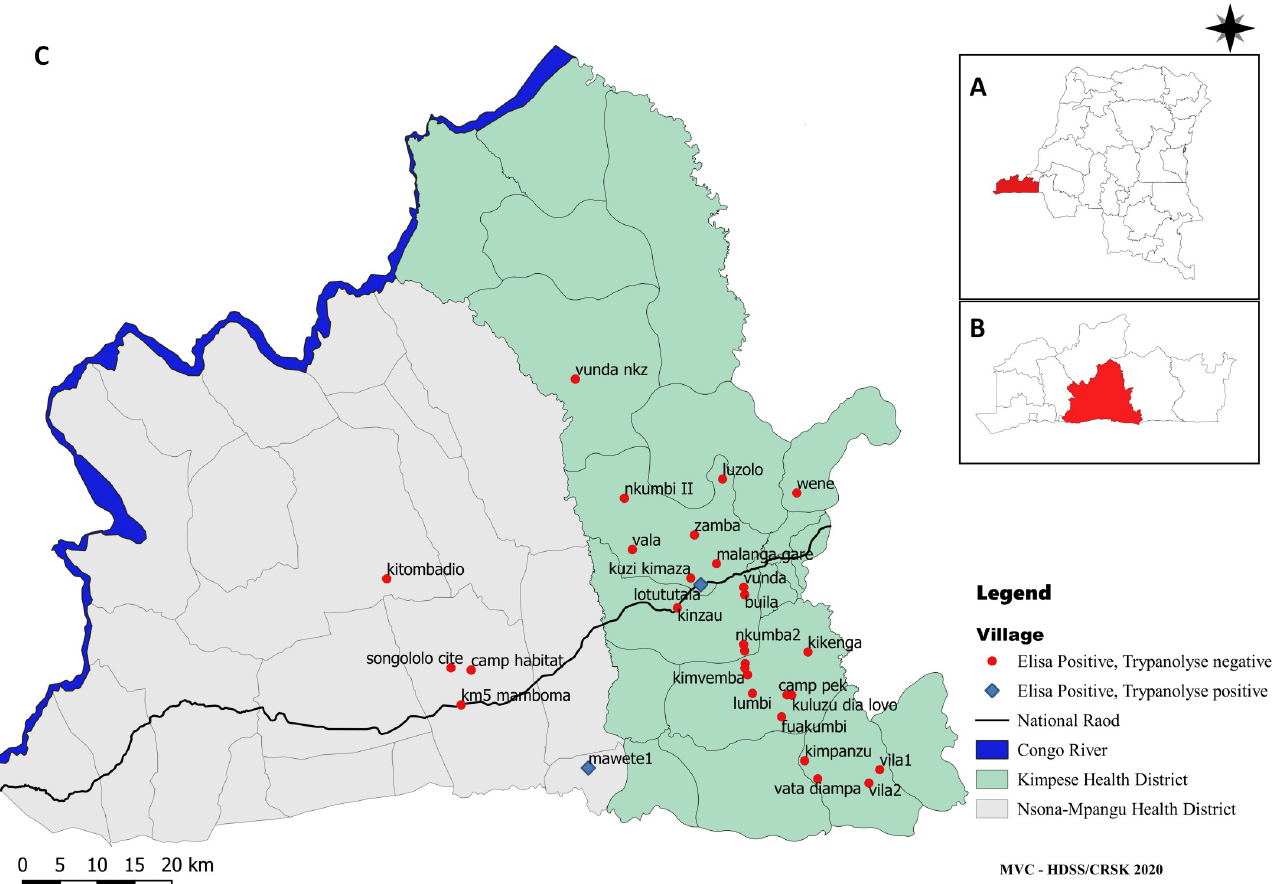
Fig 5. Mapping of the study area in Kongo Central province. A: The Democratic Republic of the Congo with Kongo Central province highlighted. B: Kongo Central province, the study area highlighted. C: Map of Nsona Mpangu and Kimpese district, villages are shown with positive ELISA and/or TL result. Map created using QGIS 3.16 based on https://www.naturalearthdata.com/downloads/10m-cultural-vectors/ and https://www.diva-gis.org/gdata.